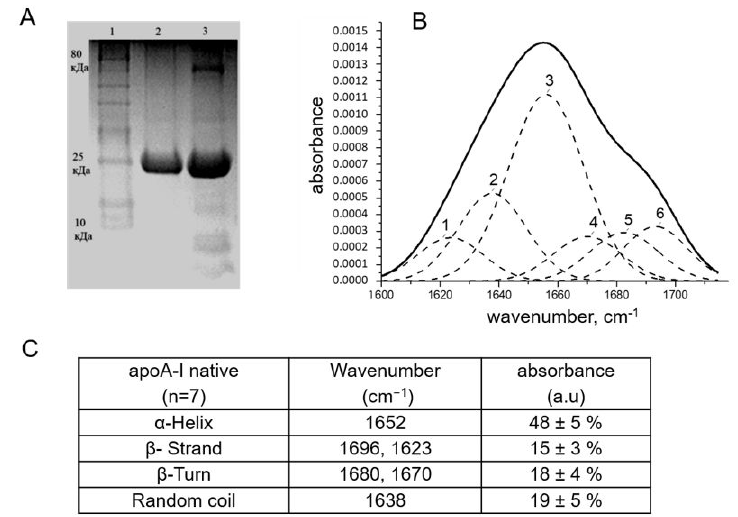
Figure 1. Characterization of the apolipoprotein A-I (apoA-I). ( A ) The protein purity: SDS-PAGE analysis. 1: standard molecular weight marker (10–80 kDa), 2: apoA-I, 3: High-density lipoprotein (HDL). ( B ) Fourier Transform Infrared Spectroscopy (FTIR) analysis of apoA-I secondary structure. Peak deconvolution of Amide I of apoA-I using OriginPro software. Peak 3— α -Helix; peaks 1, 6— β -Strand; peaks 4, 5— β -Turn; peak 2—random coil. ( C ) The secondary structure content (%) of